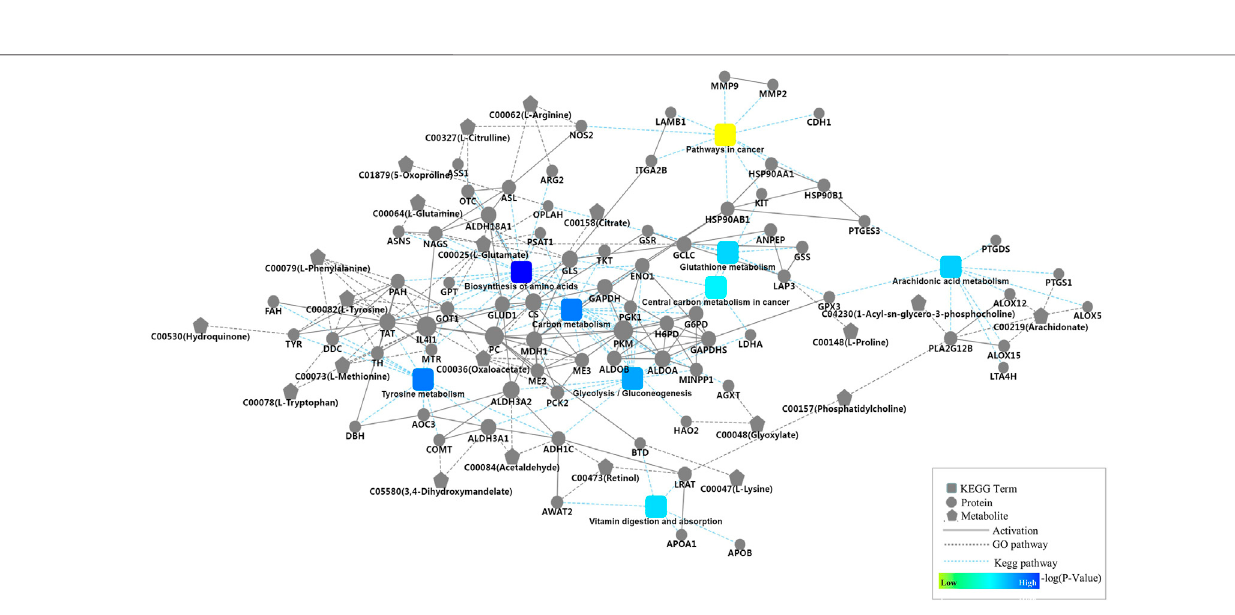
Frontiers in Molecular Biosciences |